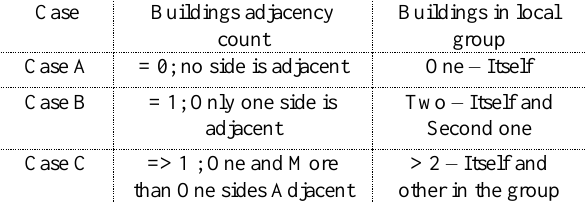
Table 4. Three cases of „building adjacency‟ and „buildings in a